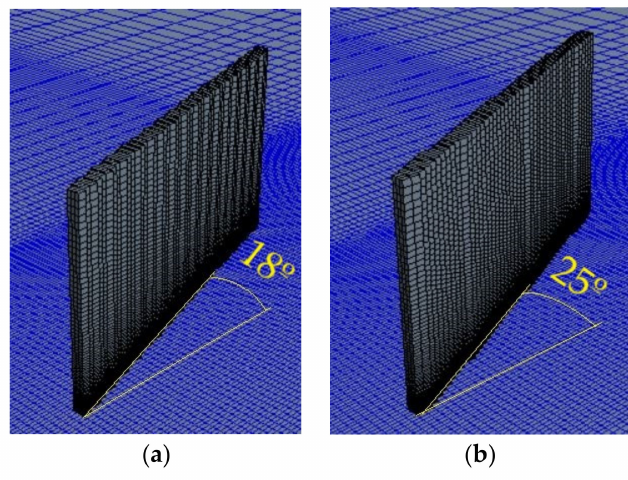
Figure 4. Cell-set construction of the VG with the cell-set model. ( a ) α = 18 ◦ ; ( b ) α =